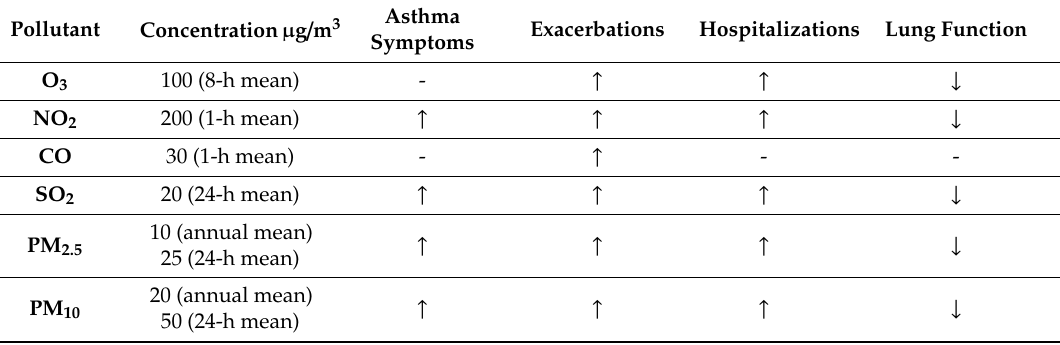
Table 1. E ff ects of outdoor air pollutants on asthma outcomes if legal concentrations are exceeded.